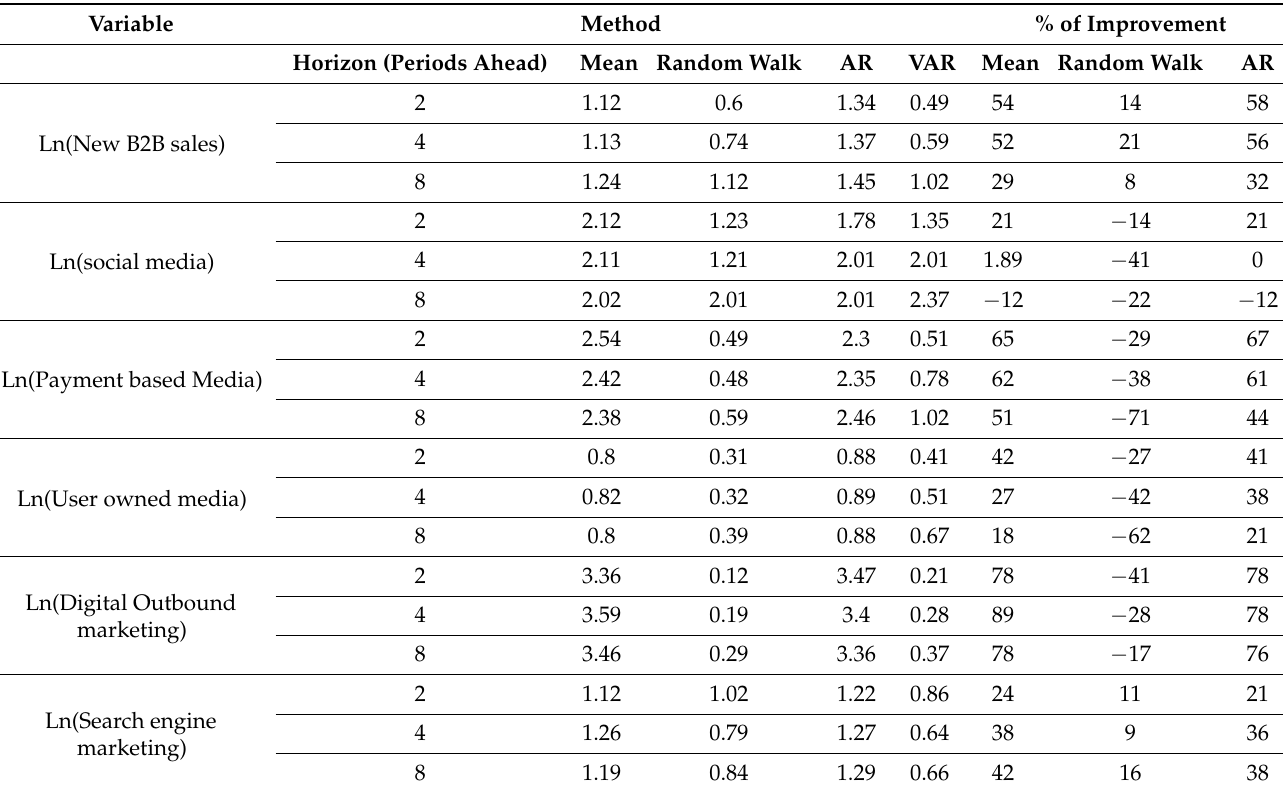
RMSE for all prediction and percentage improvement of VAR forecasts with alternative methods.